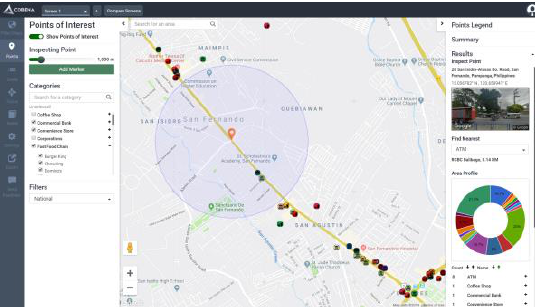
Figure 4. Site inspection for a specified radius, with a profile of the area summarized in the right